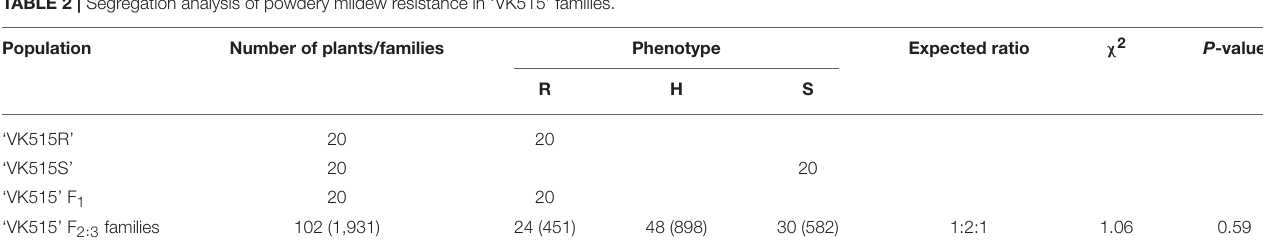
TABLE 2 | Segregation analysis of powdery mildew resistance in ‘VK515’ families. Population Number of plants/families Phenotype Expected ratio χ 2 P -value R